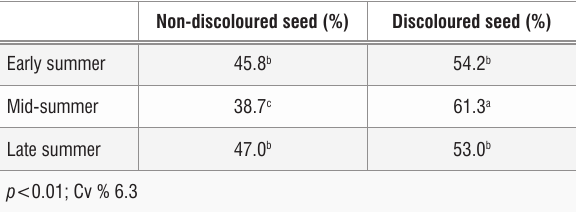
Planting date × seed